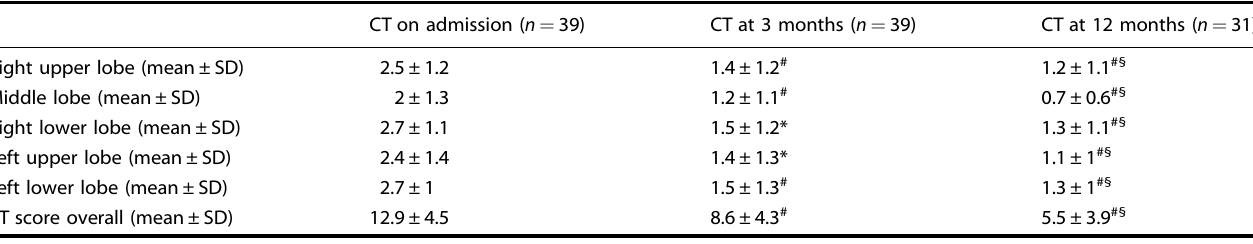
Table 3. CT score (0 – 5) per lobe and overall (0 – 25) on admission, at three-month and at 1-year follow-ups.